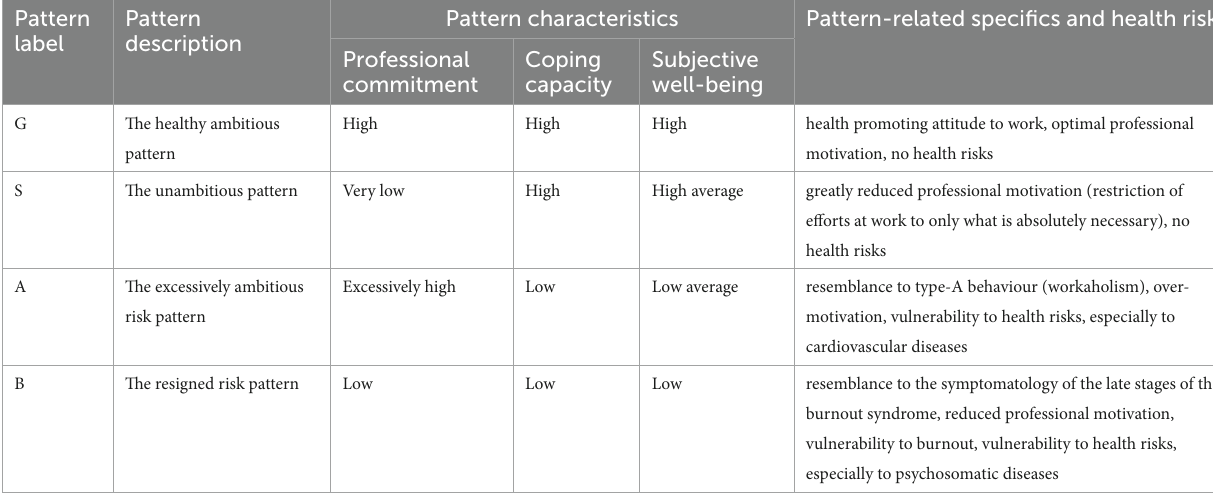
TABLE 1 Description of the four work-related patterns, their characteristics and specifics. Pattern